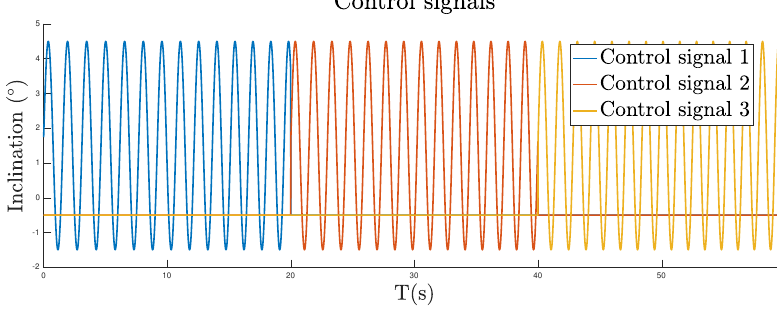
Figure 14. Test 2 input